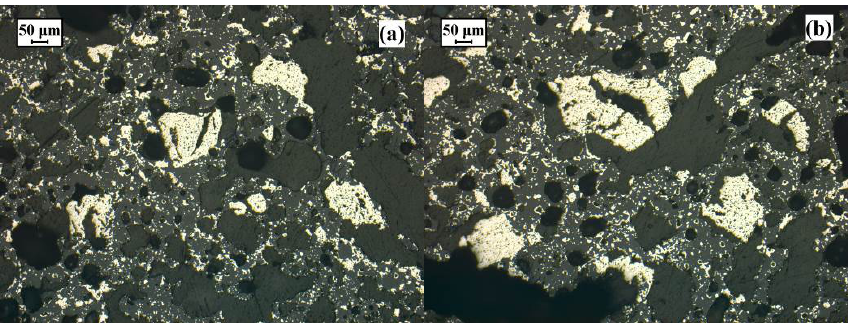
Figure 14. Distributions of metallic iron grains in reduced pellets at 0.3 binary basicity (( a , b ) inner and outer layer, reducing at 1350 °C for 25 min with a total C/Fe mass ratio of 1.0).